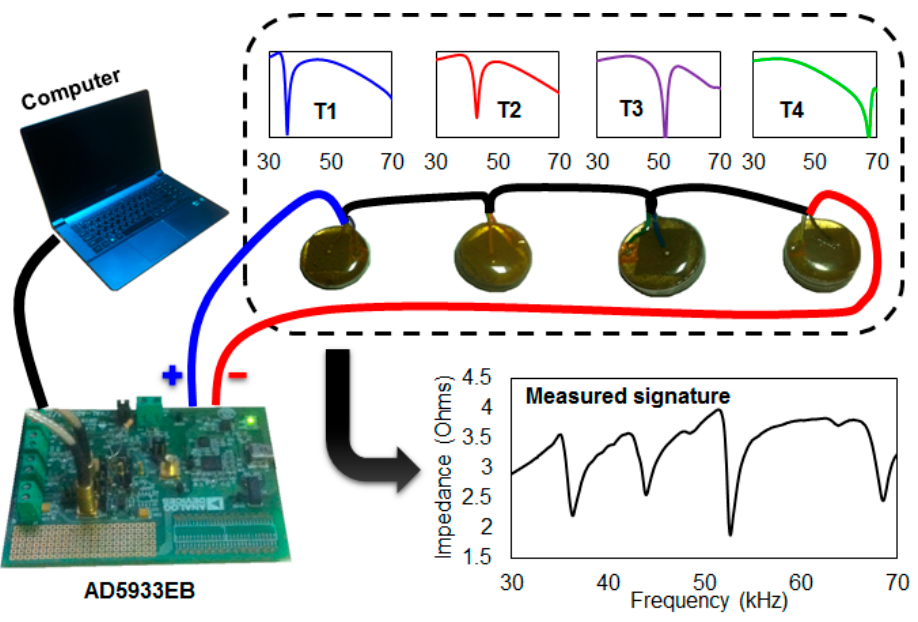
Figure 1. A low-cost electromechanical impedance method system setup.